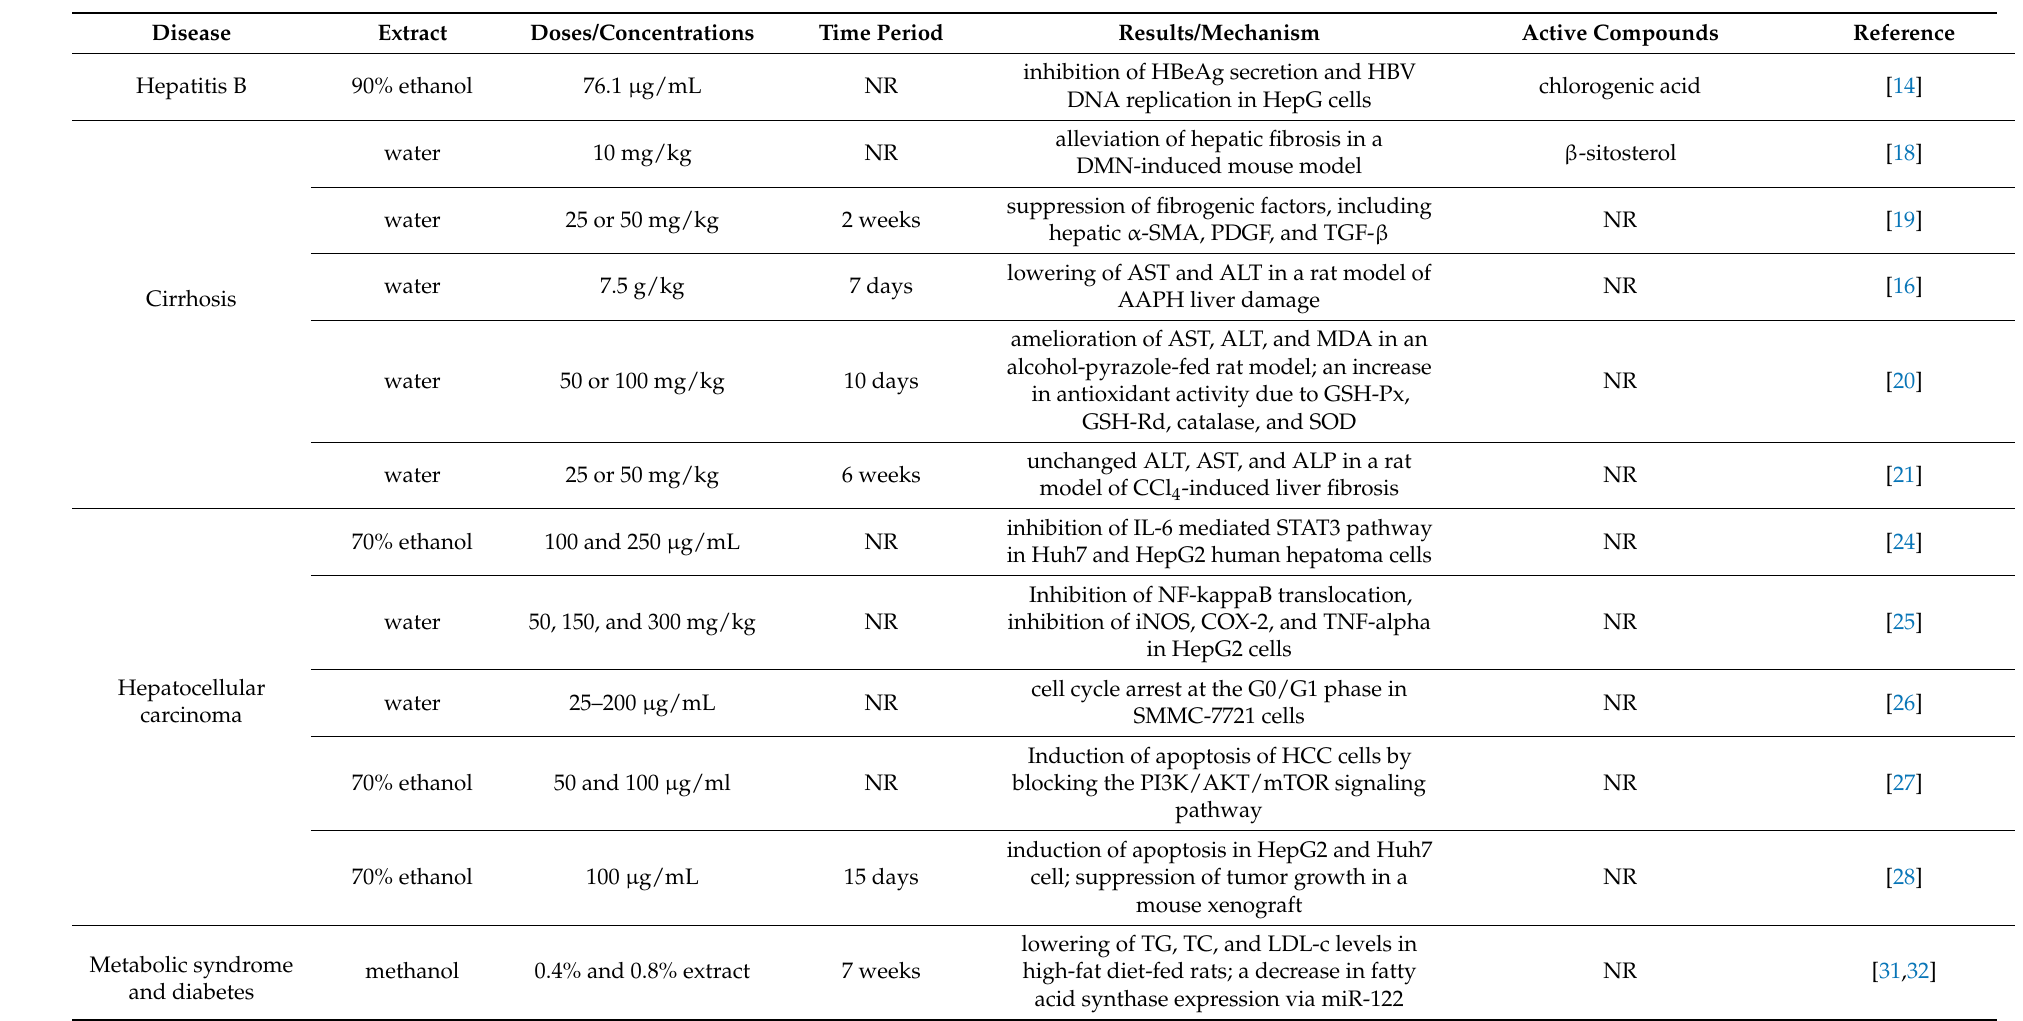
Table 1. Experimental therapeutic effects of Artemisia capillaris